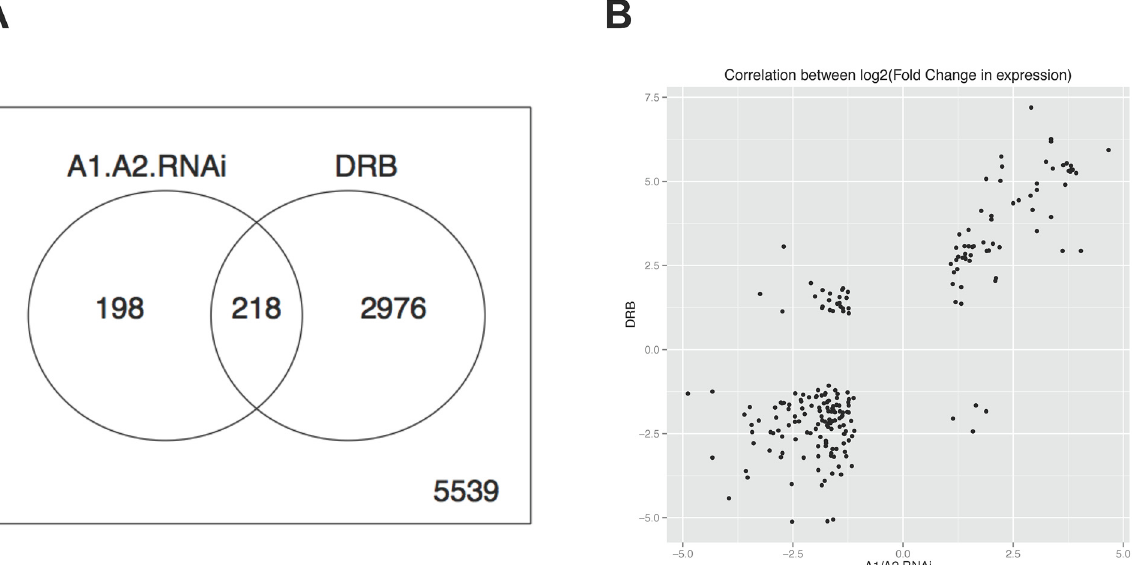
Fig 6. Impact of A1/A2 depletion and DRB on gene expression. A , The transcriptome of untreated (NS), A1/A2-depleted by RNAi and DRB-treated HCT116 cells was sequenced and reads were assigned. The Venn diagram depicts the number of genes in each sample that display a difference in expression relative to the NS sample, and only includes genes displaying a log2 (fold change) (cid:1) 2 with a correction for genes expressed at lower level using the following equation: corrected-log2(fold change) = log2(fold change) + 1/gamma^(exp-exp.offset), where gamma = 5 and exp.offset = 0, exp is the average expression level expressed as base 10 log, and fold change is the measured fold change in expression. The p -value of the DRB and Δ A1/A2 overlap is 1.4e-12 (Fisher ’ s exact test). B , Correlation map plotting the expression changes for the overlapping set of reactive genes in the DRB-treated and siA1/A2-depleted samples. Only genes with fold changes (cid:1) 2 are considered. The correlation coefficient is 0.692 (Pearson correlation ^2).